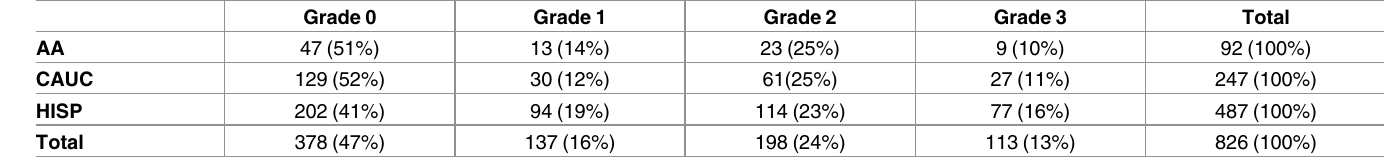
Table 3. EIGENSTRAT defined race-ethnicity differences in collateralization within obstructive CAD